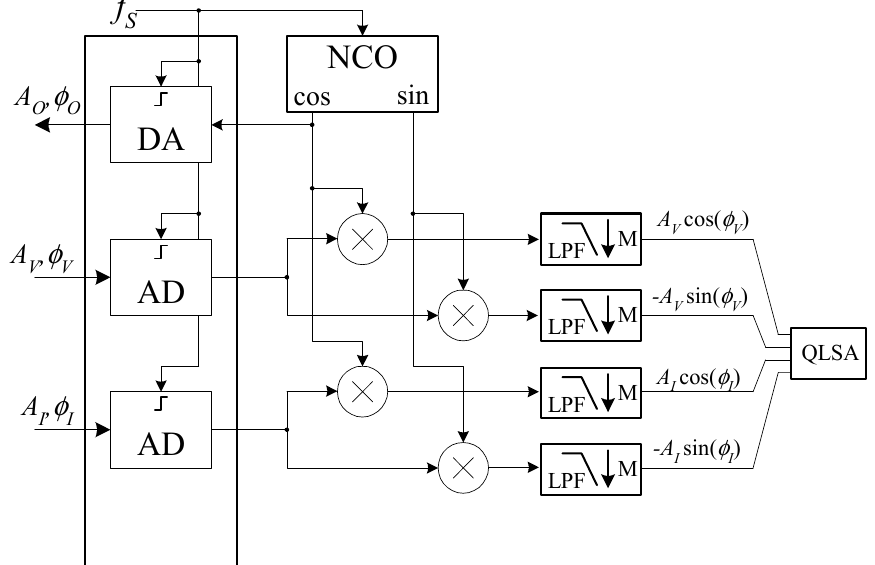
Figure 7. Schematic diagram of the operation of the Digital Signal Processing (DSP) section of the system software.